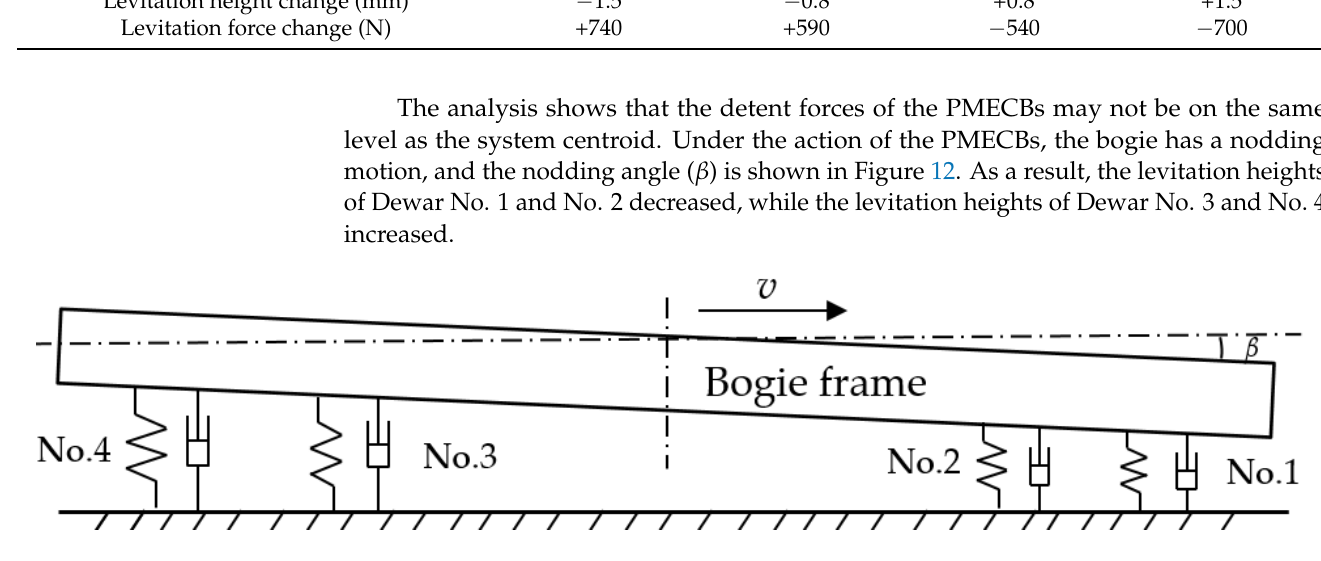
Figure 13. The change process in the nodding angle ( β ) of the bogie at initial speeds of V 0 = 60 km/h, 144 km/h, 300 km/h, 400 km/h and 600 km/h and under 10 mm air gaps. 5. Conclusions In this paper, the mathematical models of the detent forces of PMECBs installed on an HTS maglev test vehicle are fitted, and on this basis, their effects on the braking and levitation performance of the vehicle are studied. The results of the simulation show that the detent forces of PMECBs reach their max- imum value around 40 m/s (144 km/h) under different air gaps. Under the 10mm air gap,